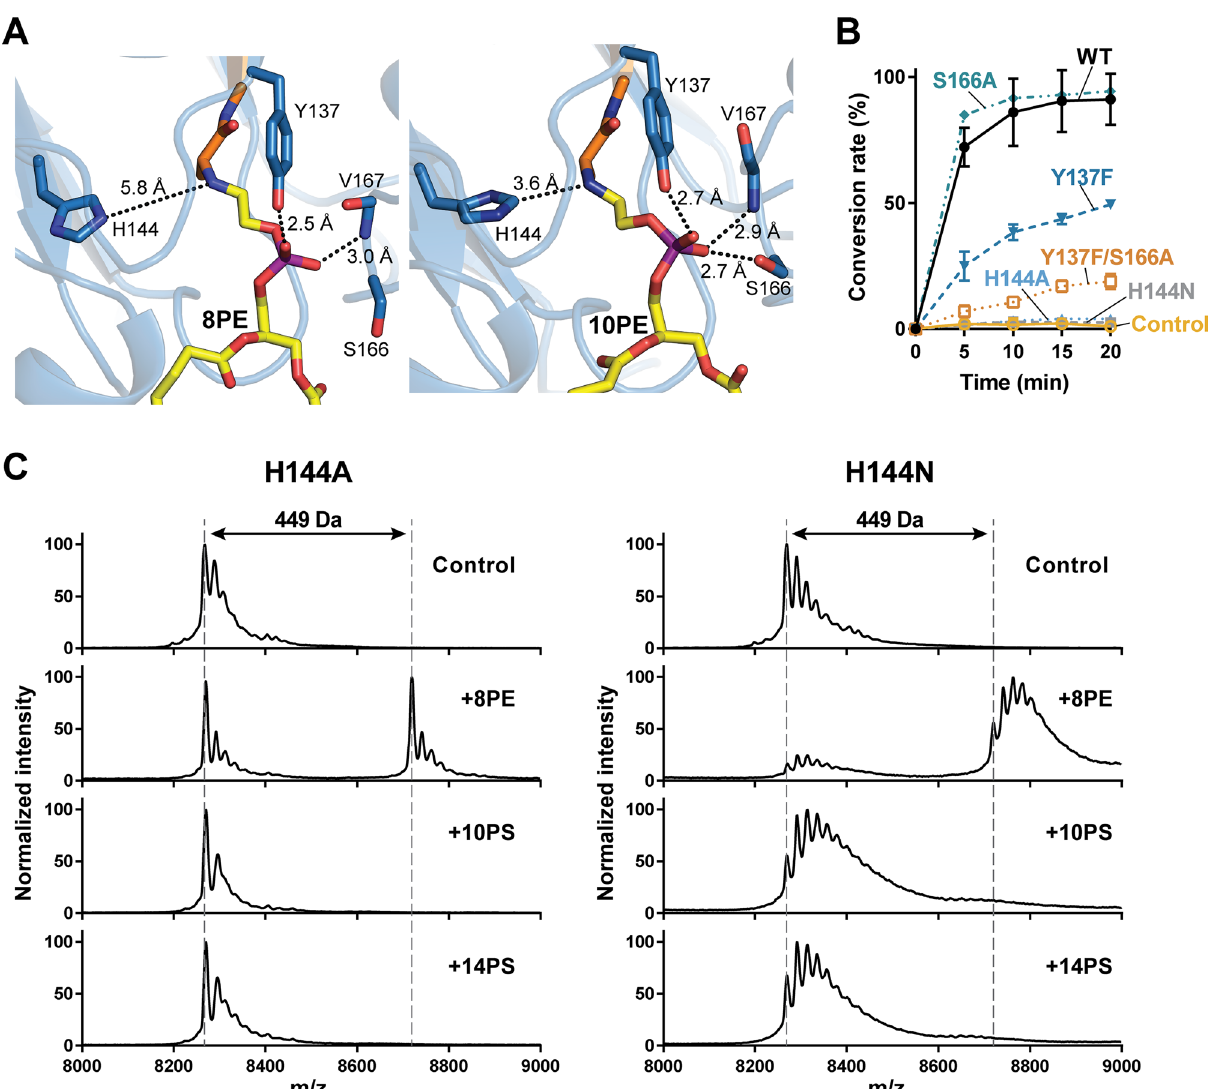
Figure 5. Active site of PS decarboxylation. ( A ) Close-up views of the active site of 8PE-PSD (Left) and 10PE-PSD (Right). Hydrogen bonds and distances between amine group of reduced Schiff base and His-144 are shown in dashed lines with an averaged distance from all protomers in the asymmetric unit. ( B ) LC–MS analysis of the PS decarboxylation activity by the wild type and mutant proteins. Conversion rate was calculated by measuring the relative peak areas of 16:0/18:1 PS and 16:0/18:1 PE. Mean and standard deviation are plotted. Experiments were performed in triplicates. ( C ) Ligand conjugation assay of His-144 mutants. Ligand conjugation by NaCNBH 3 -dependent reduction was performed in H144A (A) or H144N (B) mutants. The conjugated α-chains were analyzed by MALDI-ToF. Theoretical m/z values of α-chains are 8261 Da (control), 8712 Da (8PE-conjugated), 8813 Da (10PS-conjugated), and 8925 Da (14PS-conjugated). The MS peaks of control and 8PE-conjugated α-chains are marked as gray dashed lines for comparison of m/z values. Theoretical mass difference of control and 8PE-conjugated α-chains is 450